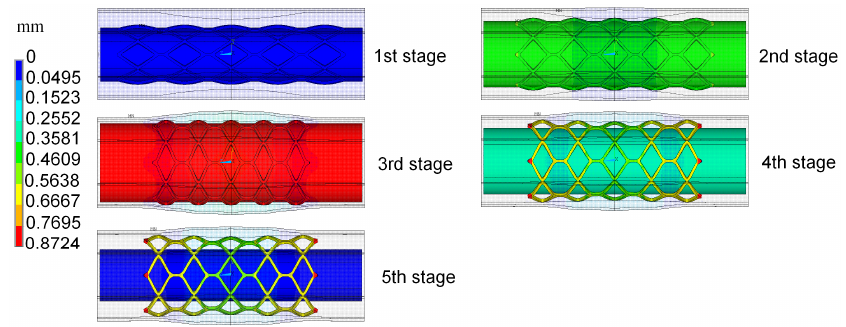
Figure 3. The expansion process of a polymeric stent in a stenotic artery displayed in symmetry.